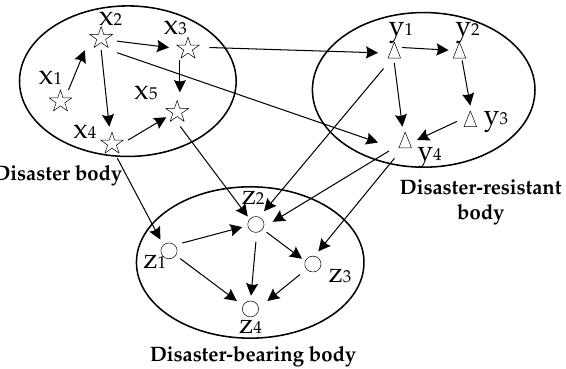
Figure 3. Relationship of scenario elements of water environmental emergencies.